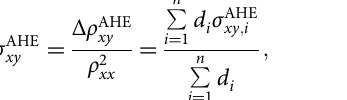
loops of the Ir moment (see inset to Fig. 3a) measured at T = 20 K and E = 11.217 keV had a coercivity of 40 mT and 24 mT, for H applied along [100] and [110] directions, respectively. A large ¼ 6 was found, much larger ratio of the orbital to spin moment L z S z ¼ 4 characteristic of the SIO-214 25 , as pre- than the nominal L z S z viously reported for manganite iridate